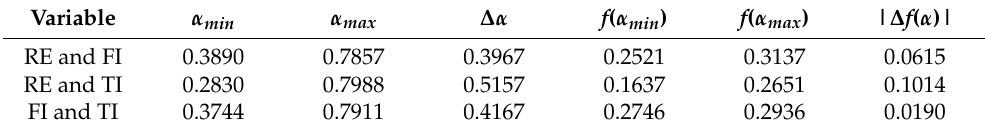
Table 2. Parameters of multifractal spectrum.